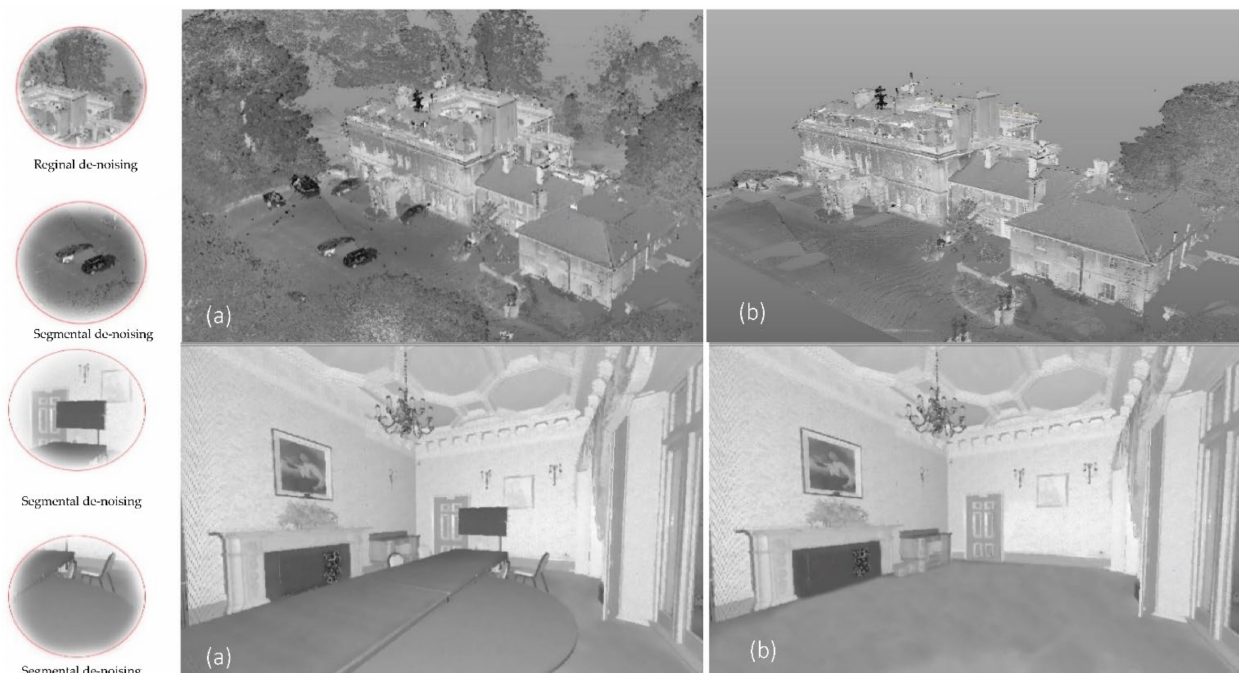
Figure 11. Point cloud de-noising: ( a ) prior to de-noising; ( b ) after de-noising. Point cloud de-noising decreases complexity and the volume of the cloud model through eliminating undesirable physical objects. Exterior cloud de-noising in the case study showed higher point reduction due to the massive number of points acquired from various elements on the site, while interior cloud de-noising showed lower point reduction due to the contextual limits of interior scans. Table 6 lists cloud points prior to and after cloud de-noising as well as redacted points from each cloud model. Table 6. Cloud points prior to and after cloud de-noising. Cloud